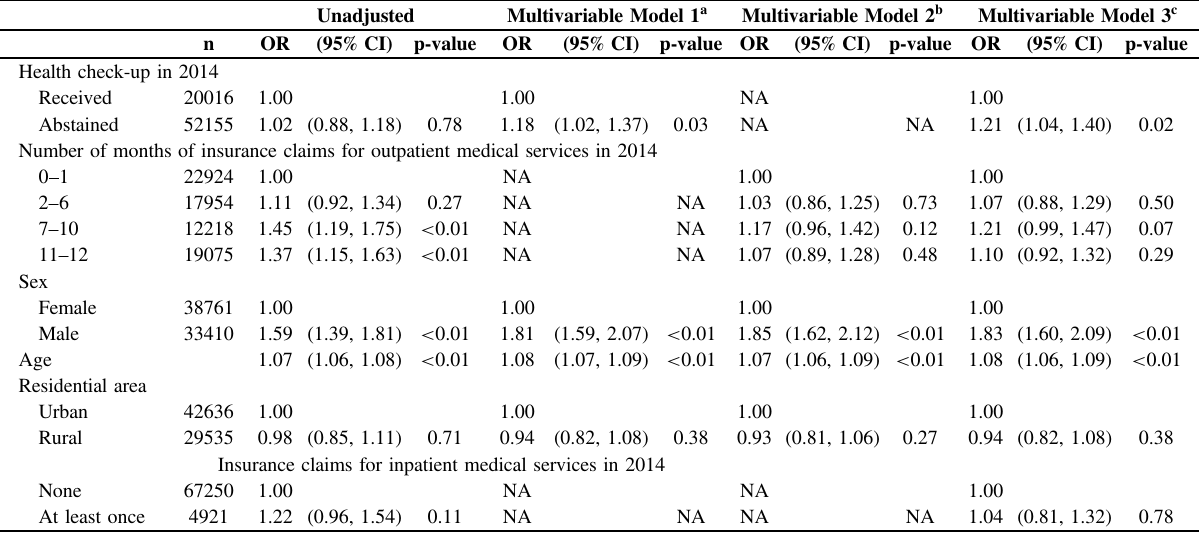
Table 2 Association between predictors and any cancer diagnosis (N = 72,171; 920 cancer cases) Unadjusted